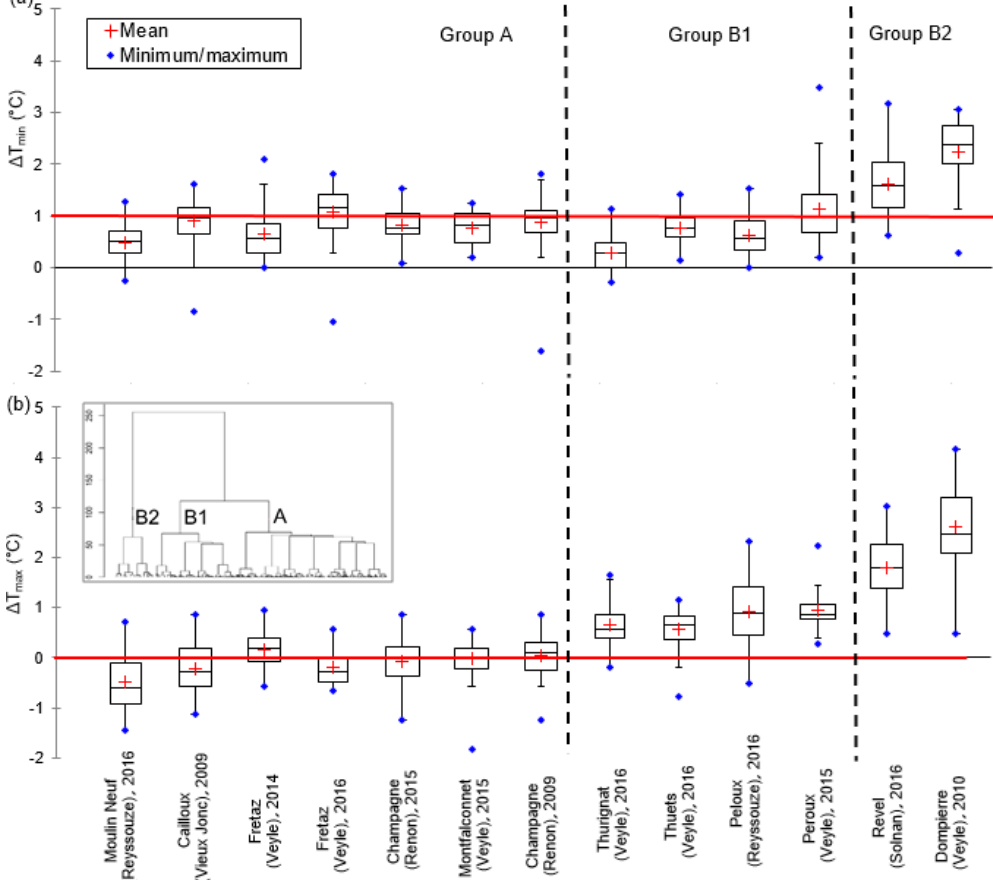
Figure 5. Box plot distribution (25%–75%) of upstream–downstream differences of daily (a) minimum and (b) maximum temperatures for all of the time series studied. (Red lines denote 0 ◦ C for (cid:49)T max and 1 ◦ C for (cid:49)T min and are drawn to help distinguish typologies.) The vertical dashed lines drawn in bold are the limits of the three typologies based on the hierarchical cluster analysis. Dendrogram hierarchical cluster analysis is shown as an inset.